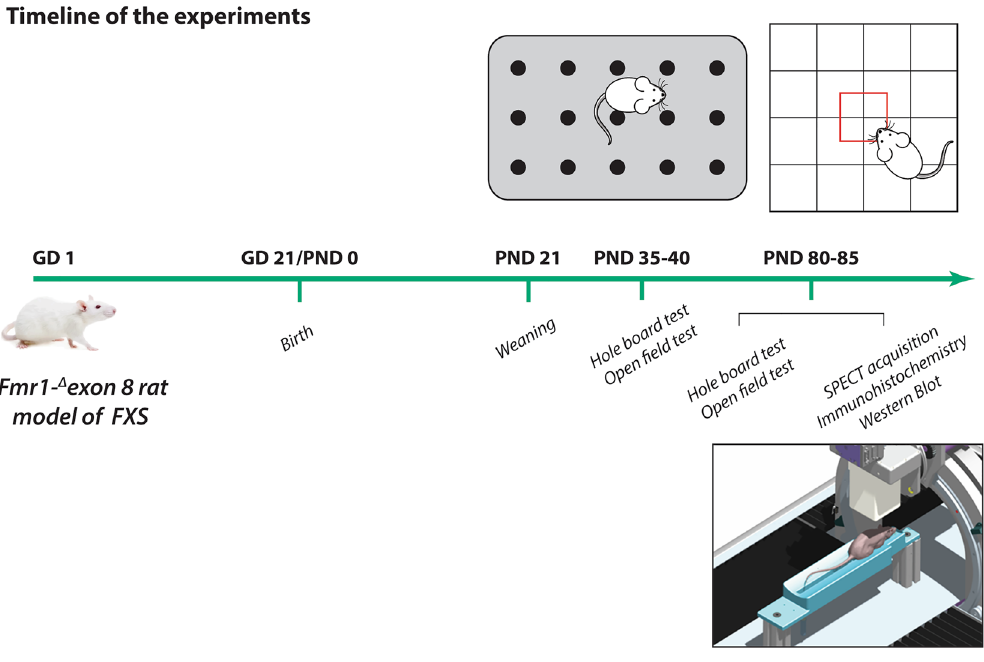
Figure 1. Timeline of the